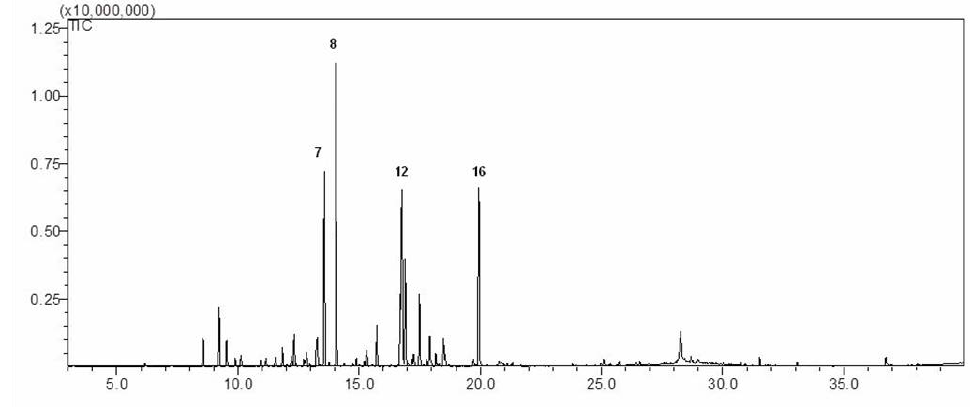
Figure 1. Total ion chromatogram of Achillea millefolium L. essential oil from gas chromatography-mass spectrometry